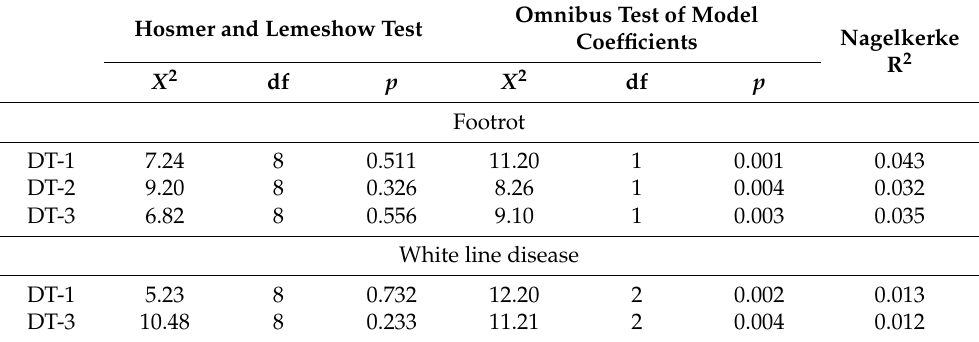
Table 1. The Hosmer and Lemeshow tests, Omnibus tests of coefficients, and Nagelkerke R 2 results for the set of three prediction models corresponding to the three hoof sites for (i) footrot and (ii) white line disease lesions.